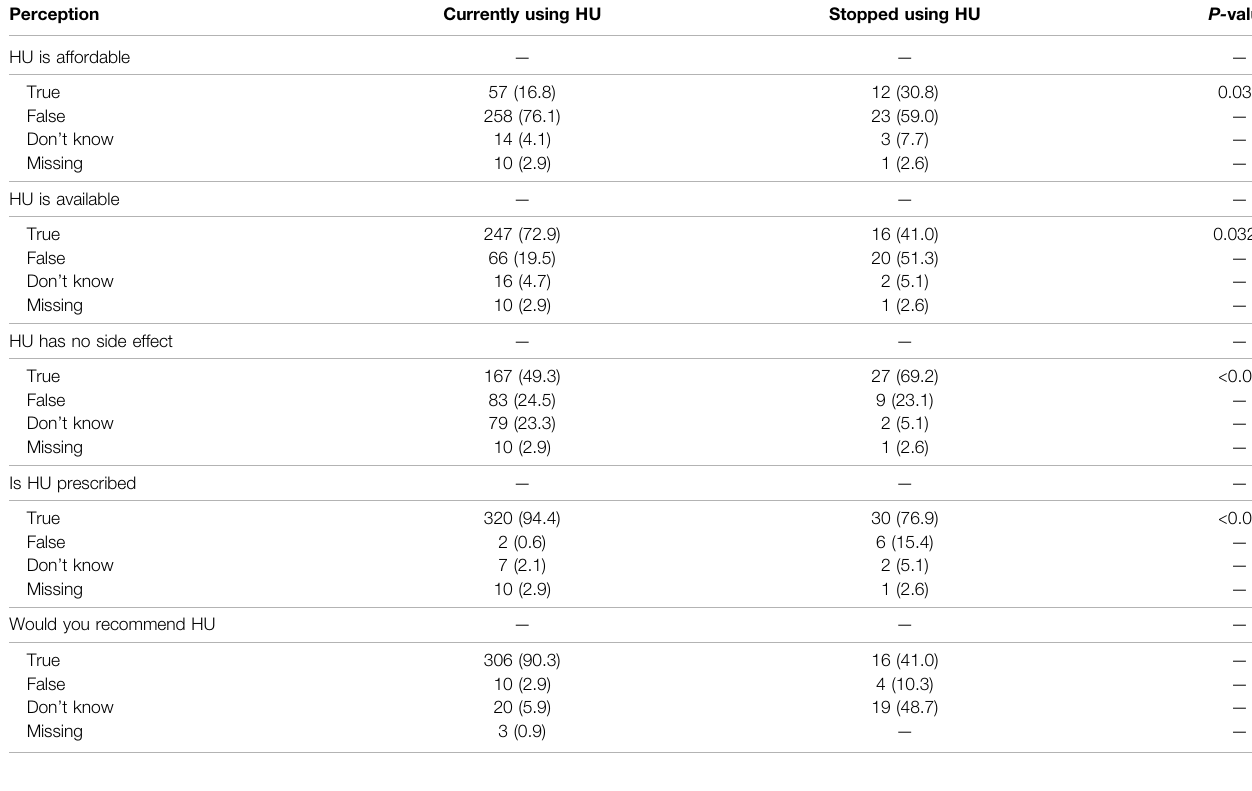
TABLE 3 | Perception on the use of hydroxyurea